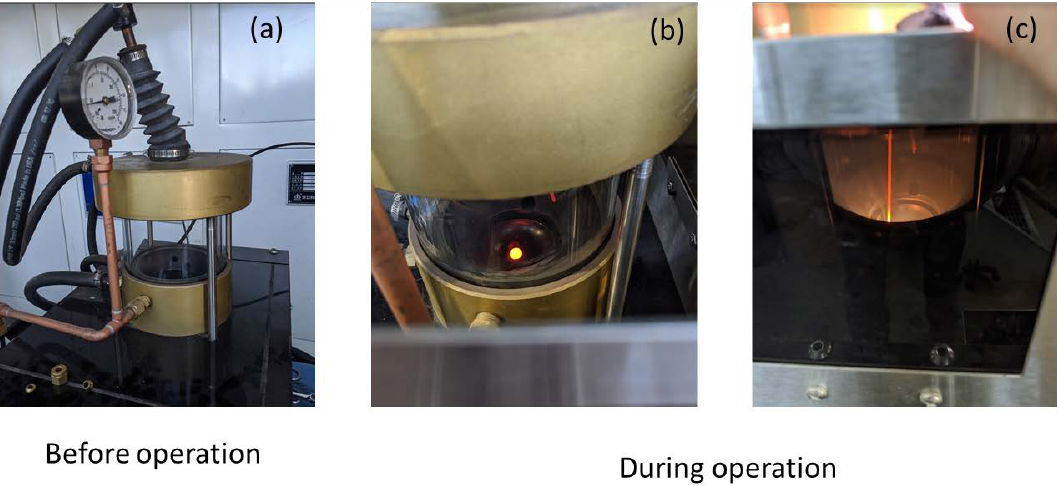
Figure A21. The digital images of an arc melting apparatus used for HEA fabrication. ( a ) . Electric Arc Melter ( b ) . Ignition ( c ) . Charging and Melting